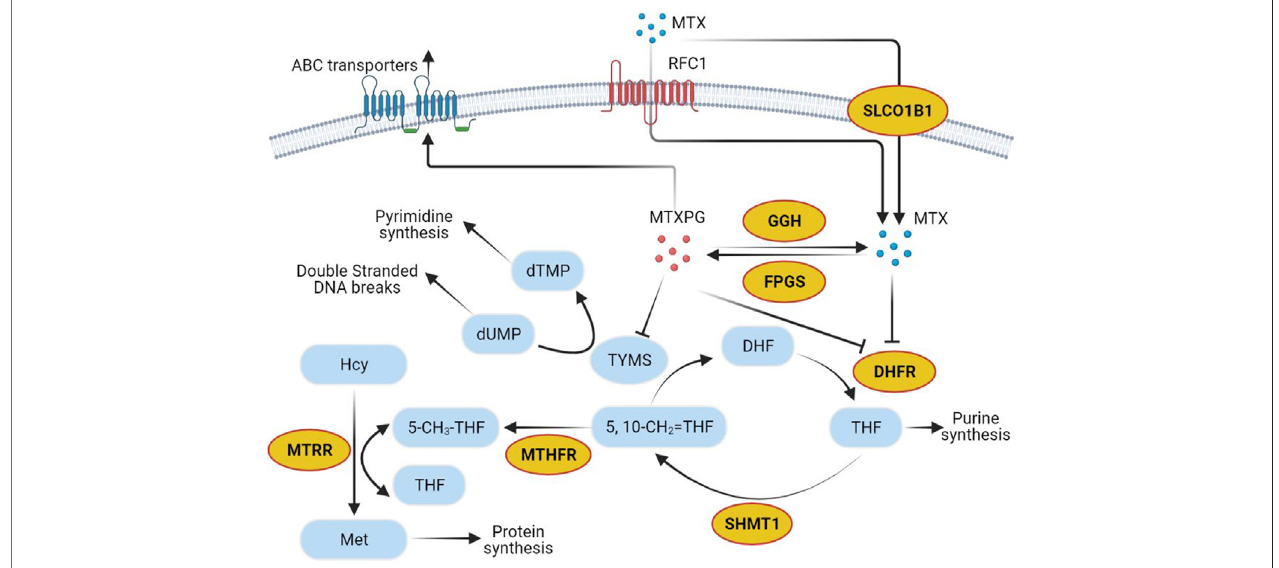
FIGURE 1 | Methotrexate pathway. Yellow circles show genes selected in the present study. Abbreviations: MTX, methotrexate; RFC1, reduced folate carrier-1; SLCO1B1, solute carrier organic anion transporter family member 1B1; dTMP, deoxythymidine monophosphate; dUMP, deoxyuridine monophosphate; TYMS, thymidylate synthetase; MTXPG, the polyglutamated forms of MTX; GGH, gamma-glutamyl hydrolase; FPGS, folylpolyglutamate synthetase; Hcy, homocysteine; MTRR, methionine synthase reductase; Met, Methionine; 5-CH3-THF, 5-methyltetrahydrofolate; THF, tetrahydrofolate; MTHFR, methylenetetrahydrofolate reductase; 5,10-CH2 (cid:1) THF, 5,10-methylenetetrahydrofolate; DHF, dihydrofolate; DHFR, dihydrofolate reductase; SHMT1, serine hydroxymethyl transferase